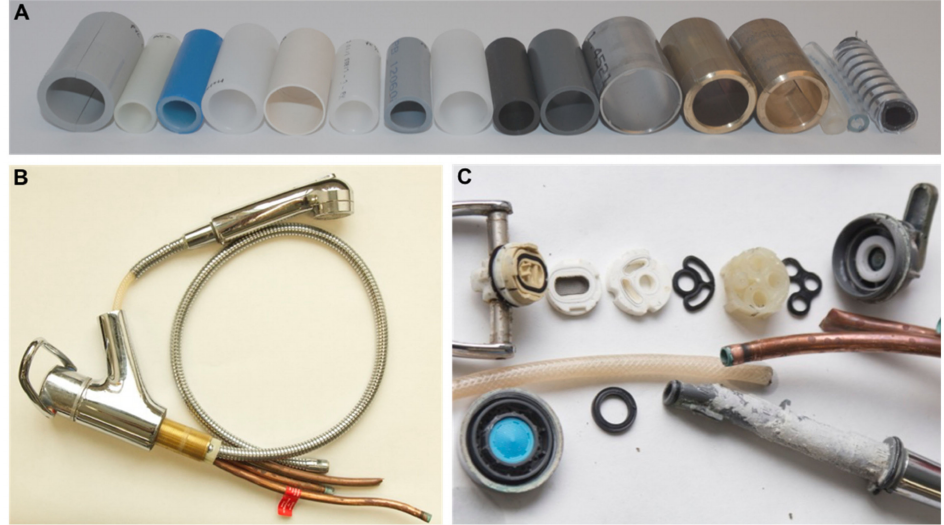
Figure 3. Variety of materials used within building plumbing systems and fixtures. ( A ) Di ff erent pipes and hoses from metals and both hard and flexible synthetic polymeric materials. ( B , C ) Materials